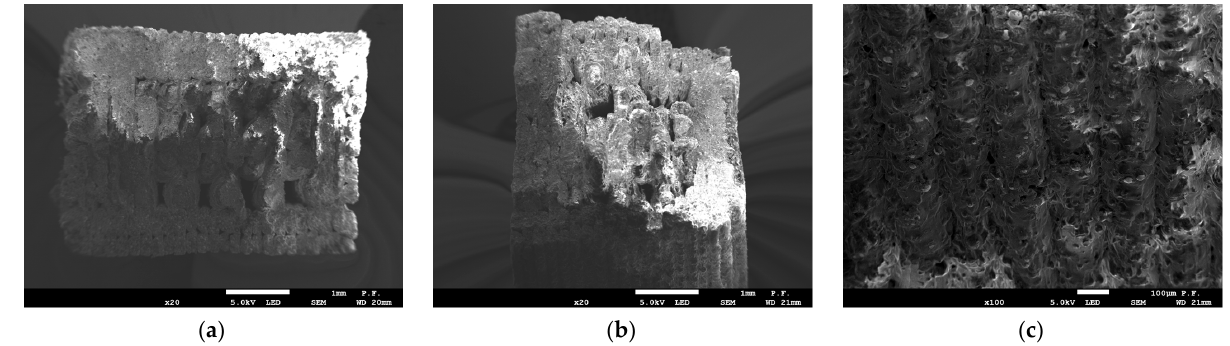
Figure 9. Cross-section of specimen 4.0 2Z composed of PLA + bronze after fracture observed with a scanning electron microscope. Observation direction—perpendicular to the cross-section; ( a ) mag-